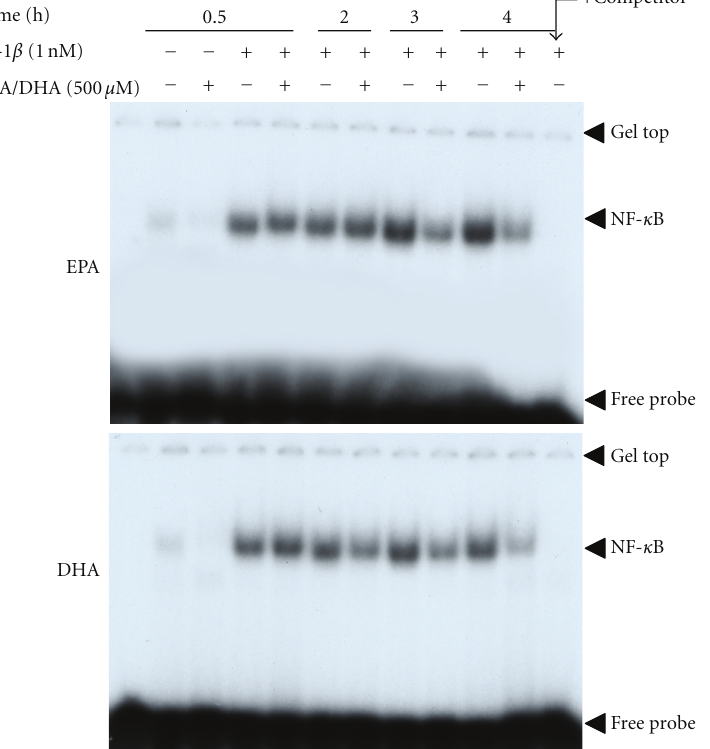
Figure 9: E ff ects of peroxidized EPA/DHA on the activation of NF- κ B. Cells were treated with IL-1 β (1nM) in the presence or absence of peroxidized EPA for 3 days and DHA for 1.5 days (each, 500 μ M) for the indicated times. Nuclear extracts (4 μ g of protein) were analyzed by